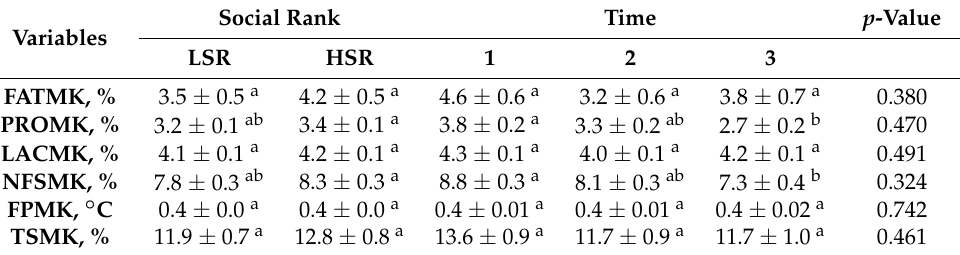
Table 5. Least-square means ± standard error for goat milk constituents, fat (FATMK, %), protein (PROMK, %), lactose (LACMK), %), nonfat solids (NFSMK, %), freezing point (FPMK, units), and total solids (TSMK, %) according to the social rank (i.e., LSR and HSR) and time (i.e., 3 times) in crossbred (Alpine–Saanen–Nubian × Criollo; n = 15) dairy goats in northern Mexico (25 ◦ N) 1,2 . Social Rank Time p -Value Variables LSR HSR